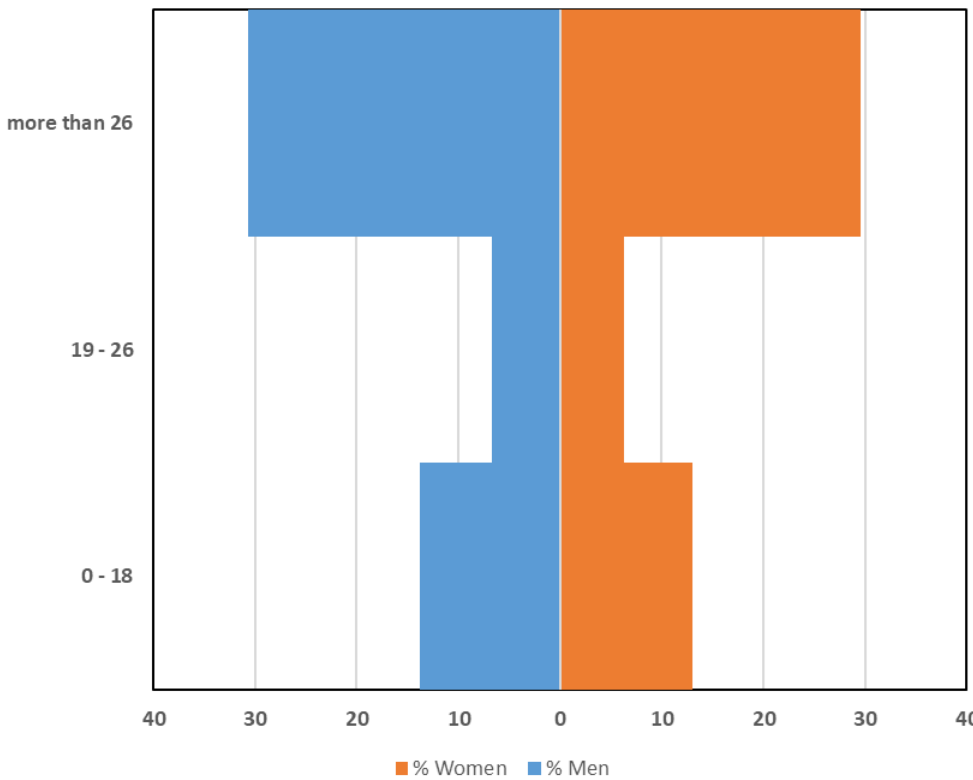
Figure 7. Sex and age of the members of the families in the irrigation districts.